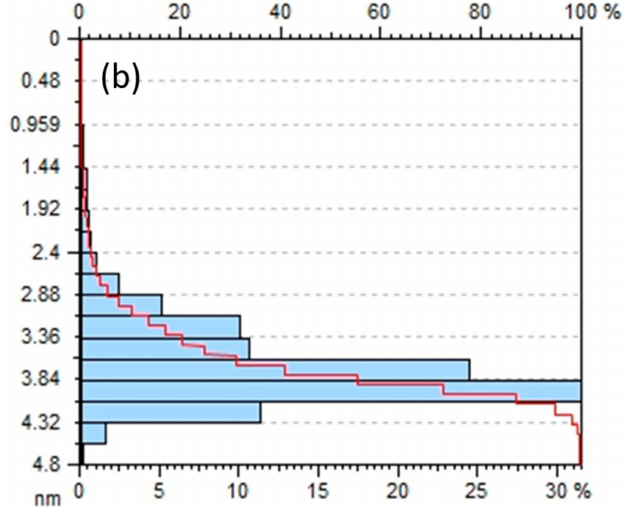
Figure 7. ( a ) 3D Atomic Force microscopy of silver nanoparticles; ( b ) average size range of AgNPs.